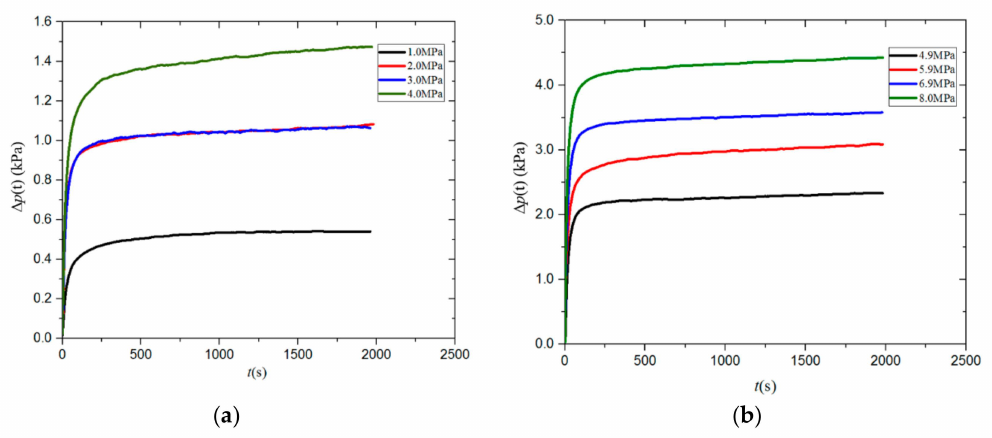
Figure A1. Pressure di ff erence signal ( ∆ p( t )) for shale particle sample 1 measured by the di ff erential pressure transducer under pressures of 1–8 MPa. ( a ) average pore pressure under 1–4 MPa with smaller ∆ p f ; ( b ) average pore pressure under 5–8 MPa with larger